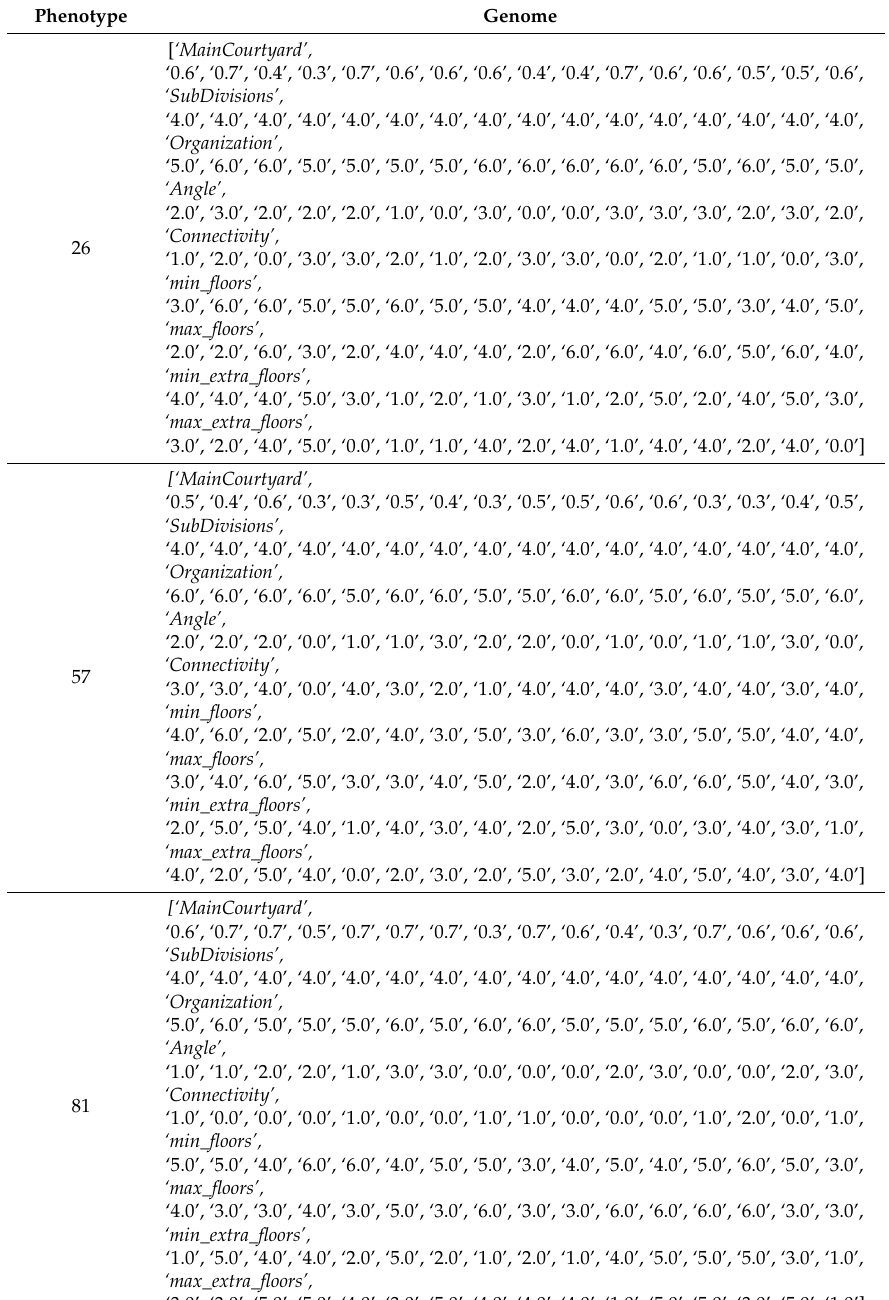
Table 1. The genomes of the phenotypes selected through the analysis of the mean fitness rank (the body part of the phenotype onto which each gene sequence is applied to is presented in